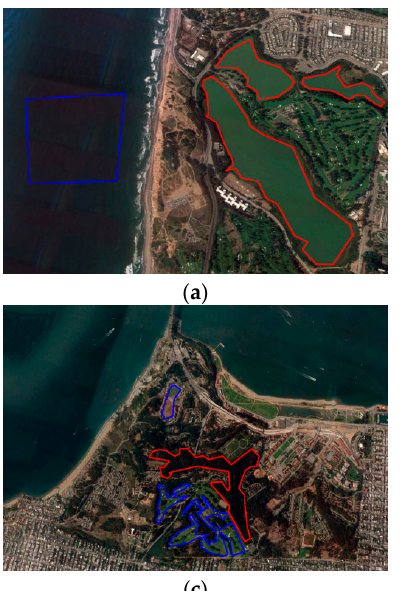
Figure 4. ( a ) The Pauli-basis images of GF-3 data sampled on 15 September 2017; ( b ) Google Earth images sampled on 2 September 2017. In ( a ), the areas inside the red boxes 1, 2, 3, and 4 represent buildings with different scattering characteristics. The areas in the green and yellow boxes are analyzed in Figure 5. Sensors 2018 , 18 , x FOR PEER REVIEW